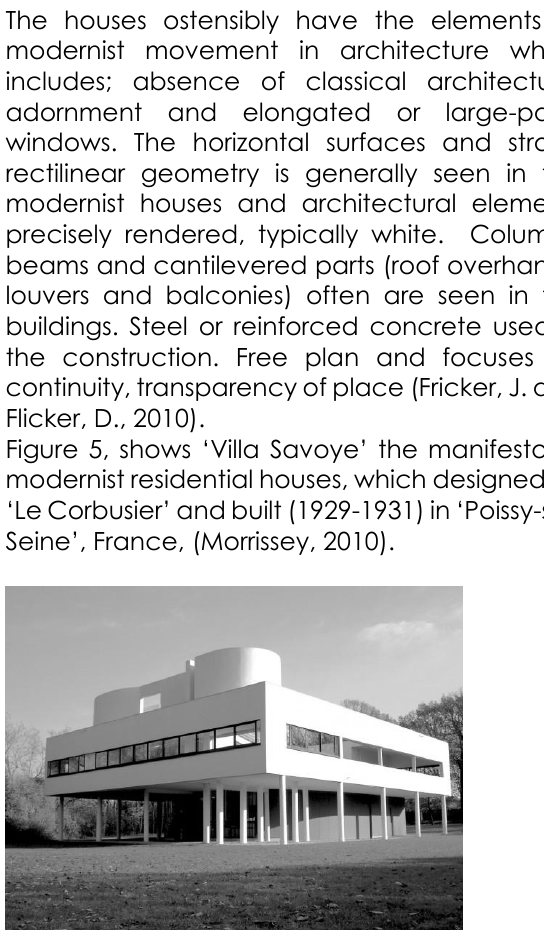
Figure 4. Villa Savoye, Le Corbusier (Morrissey,